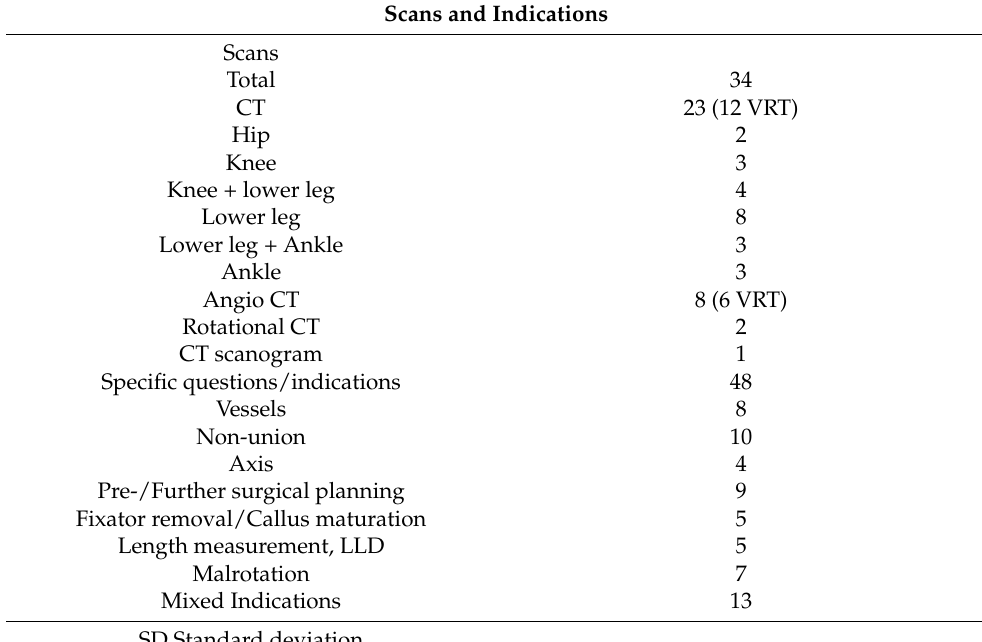
Table 3. List of all measurements, including the scans and indications for the scans; LLD, Limb length